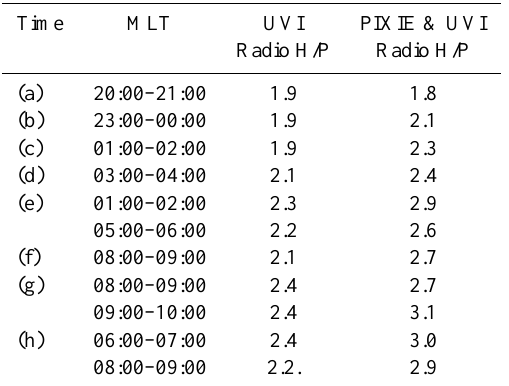
Table 3. The Hall to Pedersen conductance ratios derived from the combined PIXIE and UVI measurements, as well as from UVI data only, for the regions of maximum conductance (given in Table